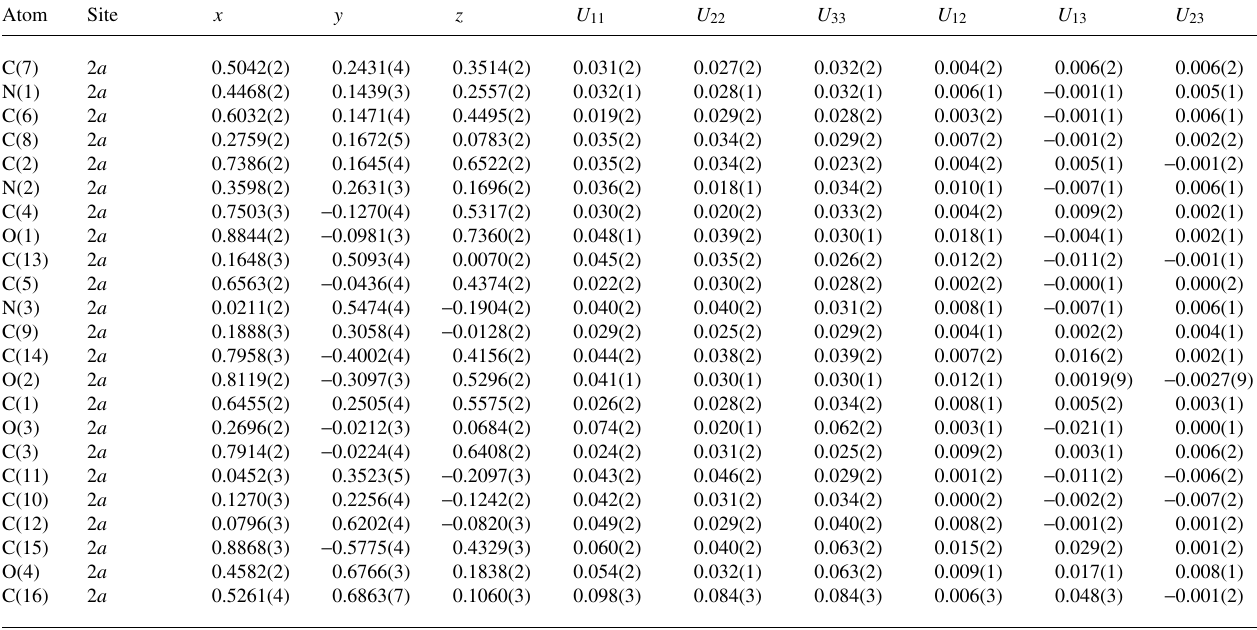
Table 3. Atomic coordinates and displacement parameters (in Å 2 )